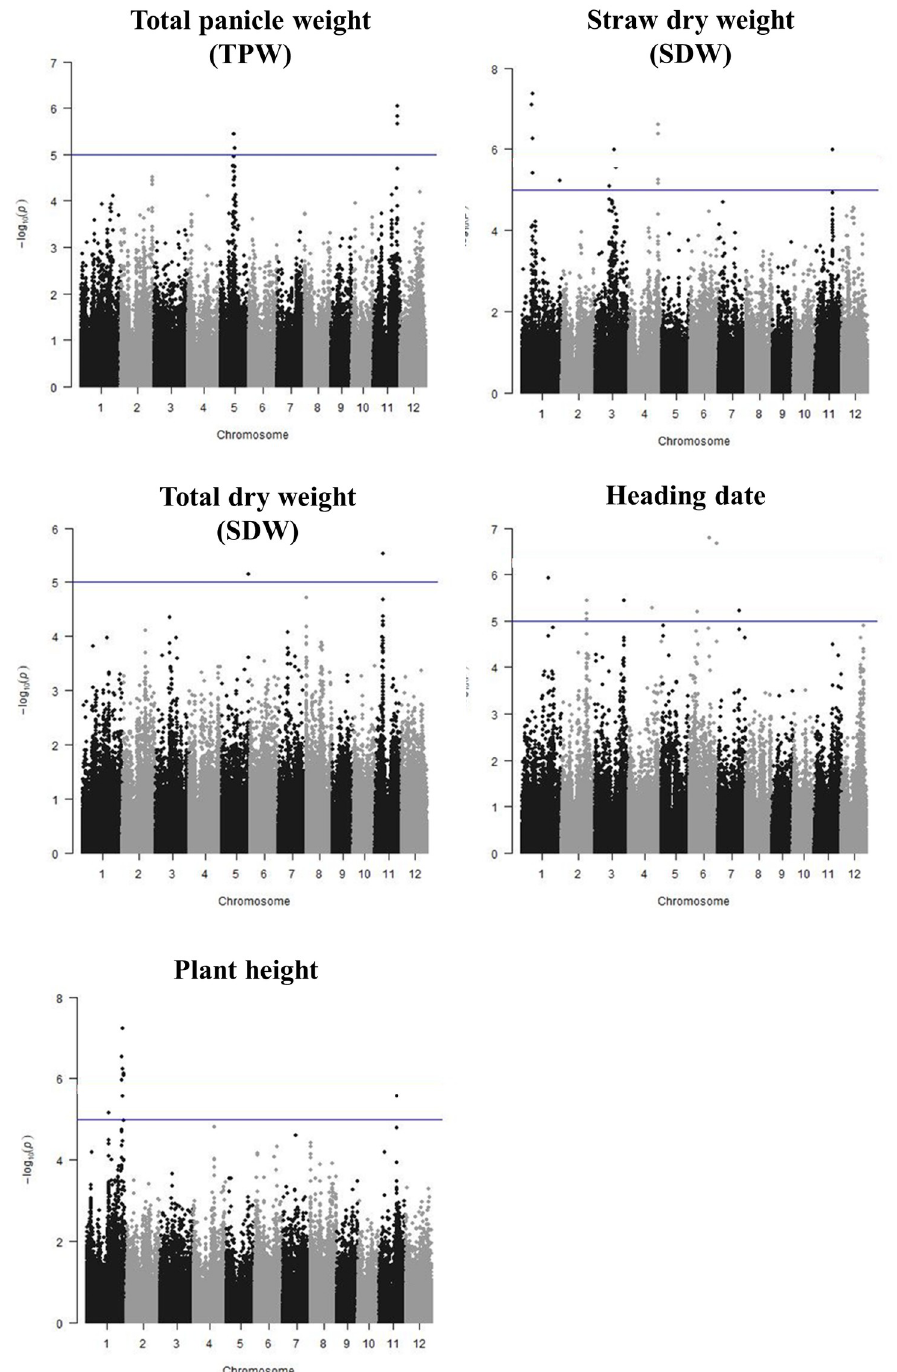
Fig 3. Manhattan plots derived from GWAS analysis for all evaluated traits. Y-axis shows the negative logarithm of the association ((-log10 (P-value)) for each SNP, while X-axis displays the SNP location along the 12 chromosomes. Vertical line indicates a -log10 (P-value) threshold of